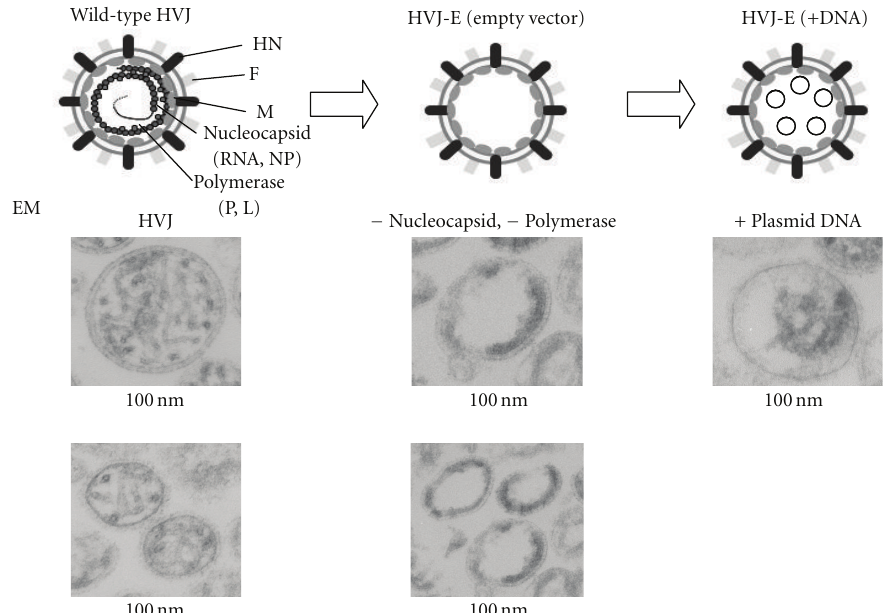
Figure 1: Hemagglutinating virus of Japan- (HVJ)- envelope vaccination: pcDNA3.1/HSP65DNA + IL-12DNA were incorporated into an HVJ-envelope empty vector (nonviral vector). Graphical representations of the HVJ-envelope empty vector in the presence or absence of DNA are shown. Electronic microscopy (EM) photographs of the HVJ-envelope empty vector are also shown.